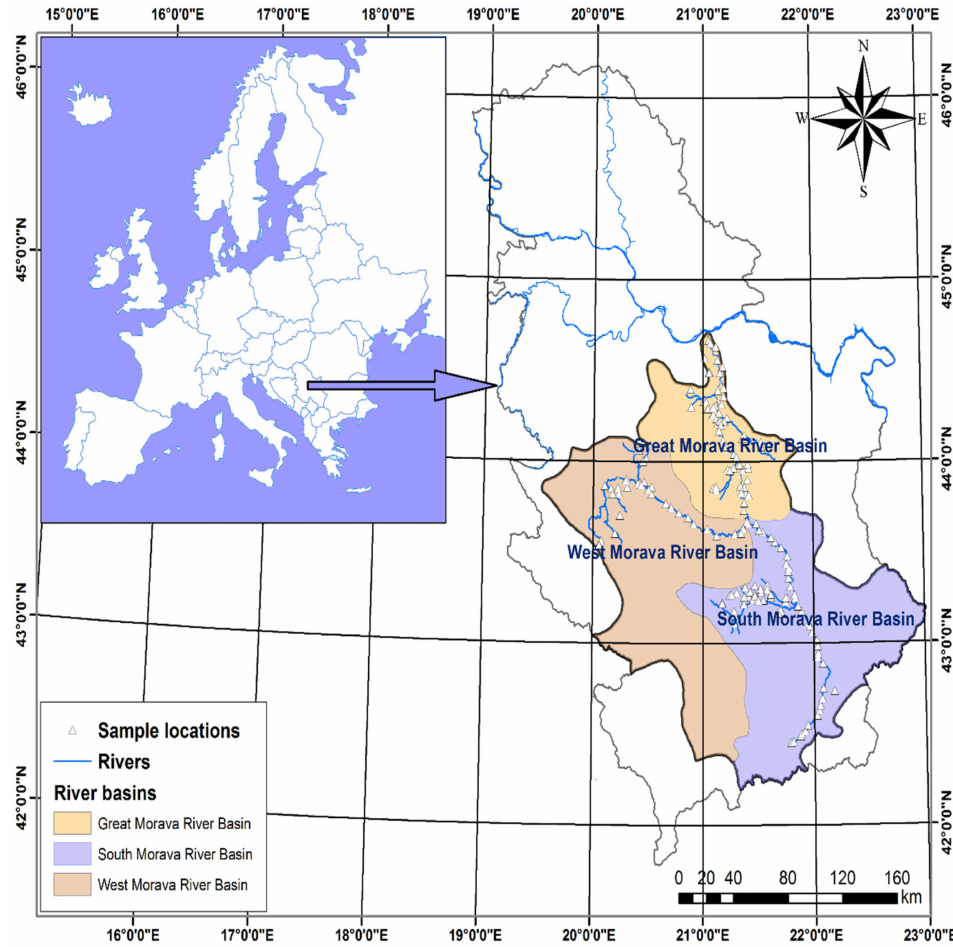
Figure 1. Study area with locations of sampling